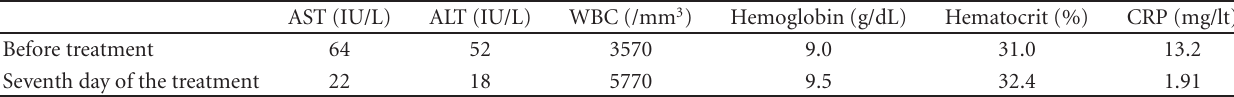
Table 1: The laboratory findings obtained at the day of hospitalization and on the seventh day of the rifampicin plus doxycycline